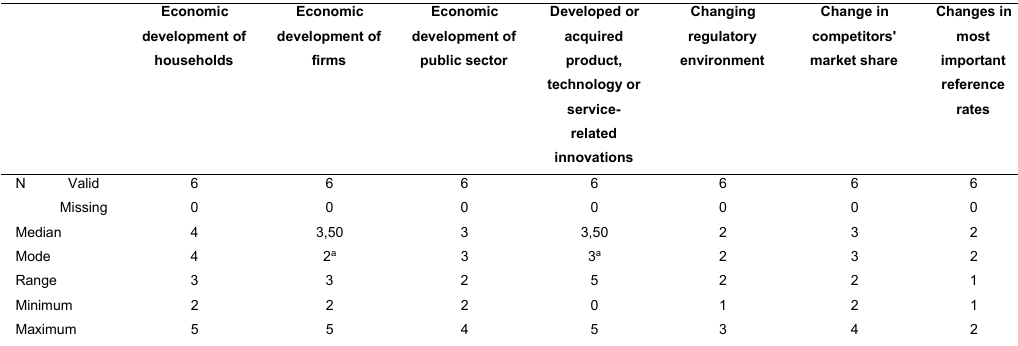
Table 8. The assessment of different factors affecting banks’ business